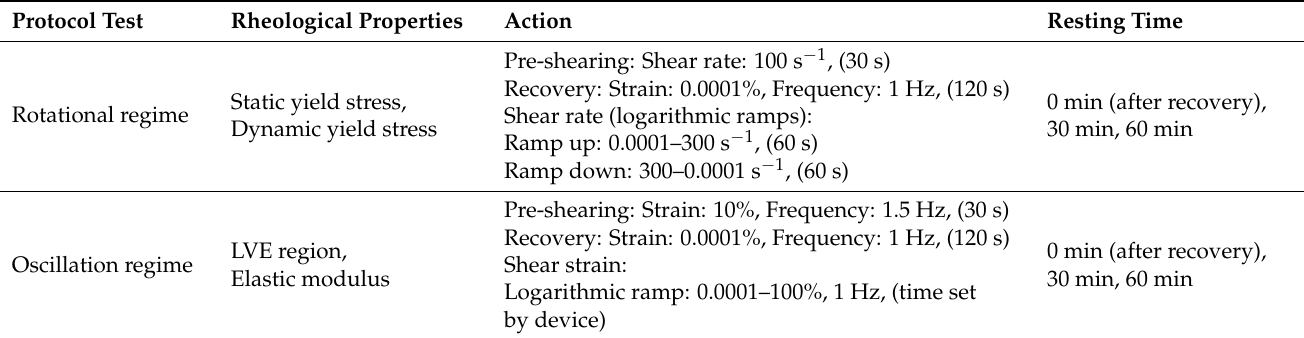
Table 3. Summary of the testing